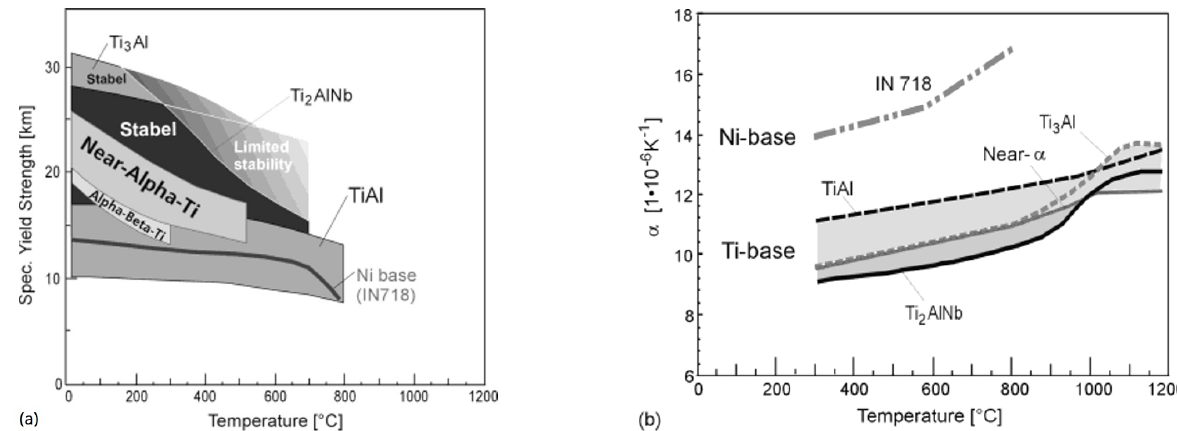
Figure 1. Temperature dependences of specific yield strength ( a ) and coefficient of thermal expansion ( b ) for orthorhombic titanium aluminide (Ti 2 AlNb and Ti-22Al-25Nb alloy) compared with near- α -titanium alloys (Timetal 834/1100), Ti 3 Al-based alloy (Ti-25Al-10Nb-3V-1Mo), TiAl-based alloy (Ti-46.5Al-3.0Nb-2.1Cr-0.2W) and nickel-based alloy (IN718). Reproduced with permission from Elsevier [4]